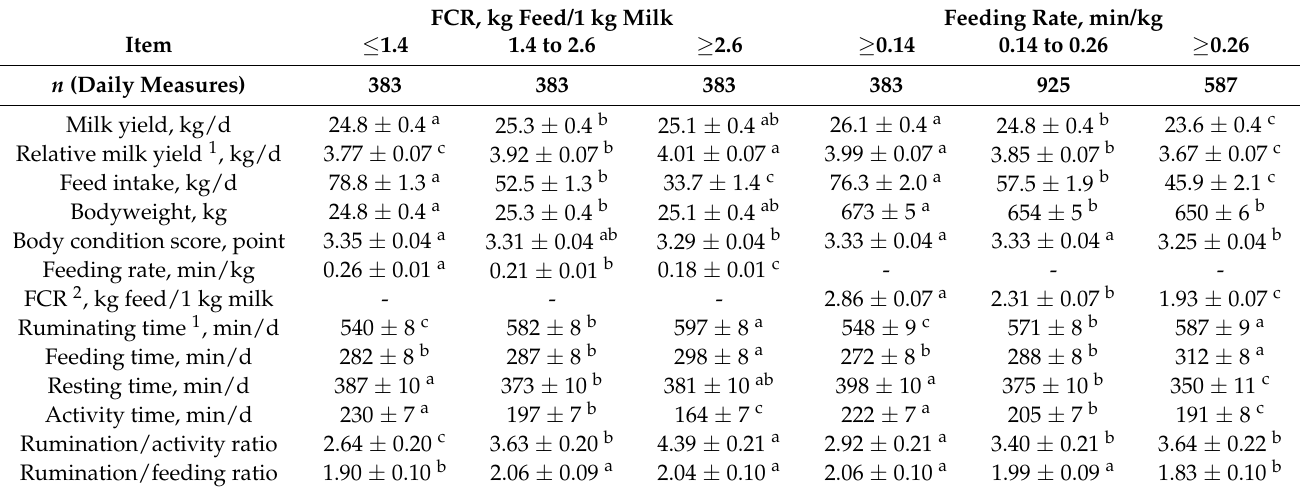
Table 4. Effects of feeding rate and FCR on evaluated